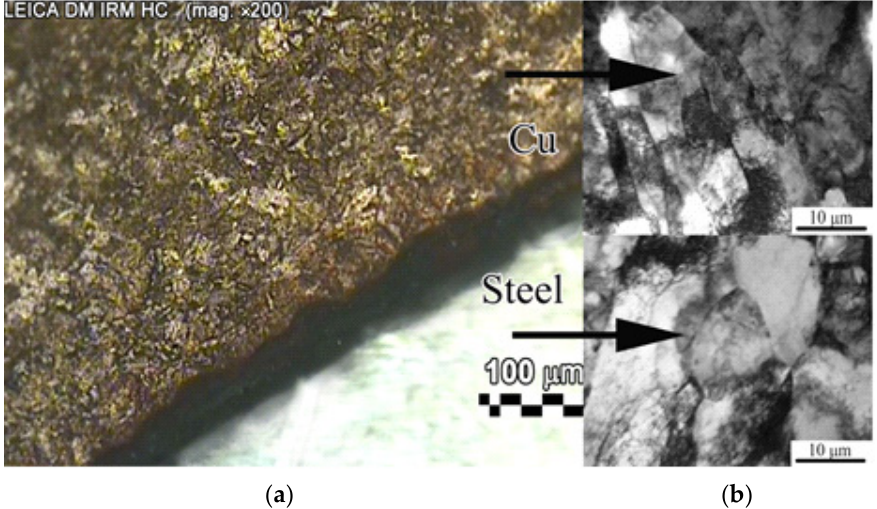
Figure 1. Microstructure of steel-copper wire (transversal section): ( a ) initial state; ( b ) after three passes by ECAP-drawing.